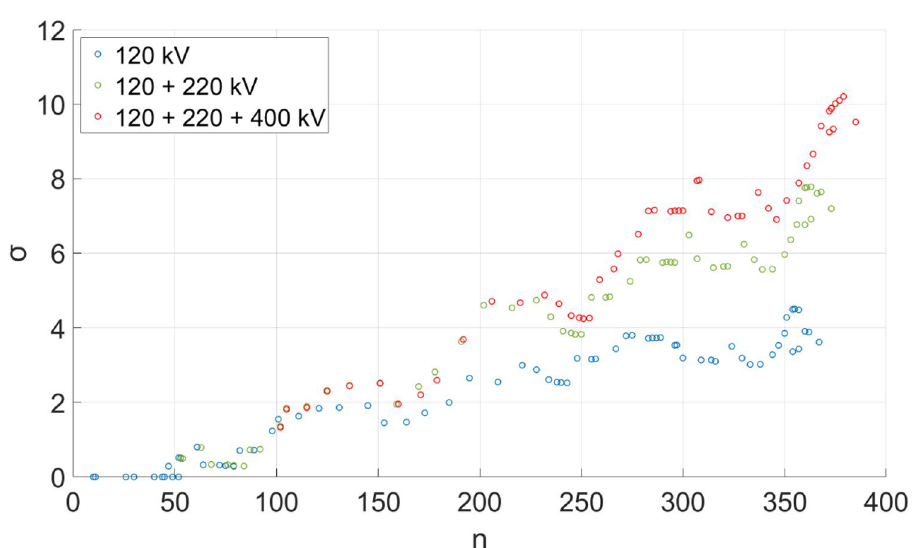
Figure 3. Relationship between σ small-world coefficient and n number of nodes for the whole network and selected sub-networks. The inclusion of 220 and 400 kV networks significantly contributes to σ